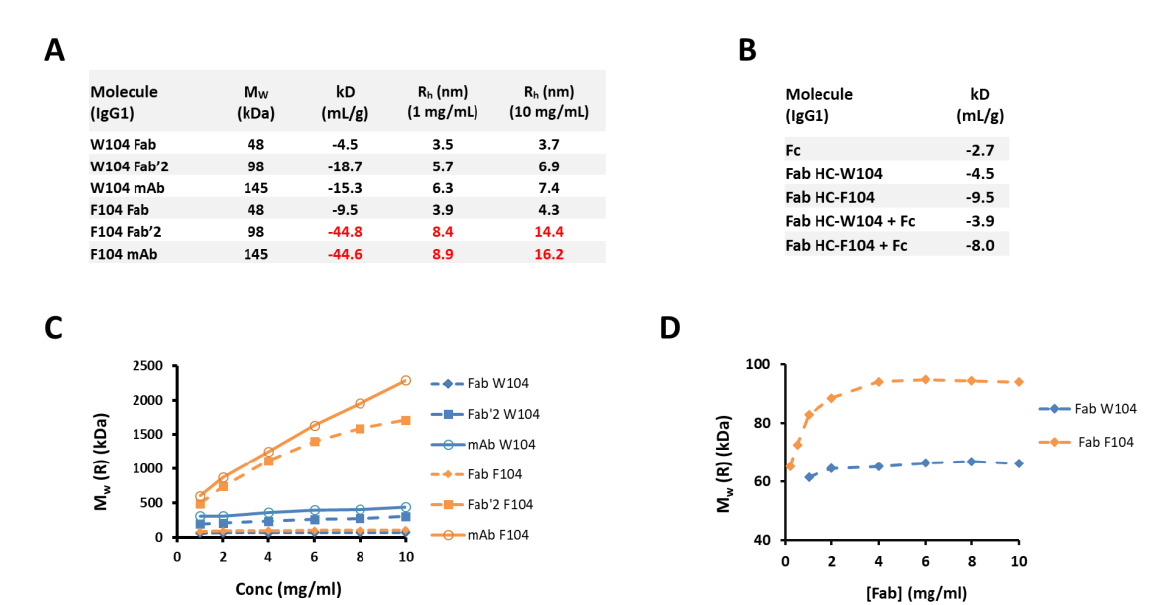
Figure 2. Dynamic Light Scattering (DLS) results for various constructs and HC-104 variants. ( A ) Tabulated molecular weight (M W ), known from sequence, and interaction parameter (kD) and hydrodynamic radius (R h ) obtained by DLS for both W104 and F104 variants in the Fab, Fab’2, and mAb forms. Highly negative kDs and large R h values are in red font. ( B ) kD tabulated for Fc and Fab constructs for W104 and F104, and Fab/Fc mixtures (1:1 molar ratio). ( C ) Calculated M w values derived from measured diffusional coefficients plotted against concentration for Fab, Fab’2, and mAb constructs for F104 (orange symbols) and W104 (blue symbols). Fab, Fab’2, and mAb are designated as diamonds, squares, and open circles, respectively. ( D ) Calculated M w values derived from measured diffusional coefficients for Fab forms only of W104 (blue diamonds) and F104 (orange squares).